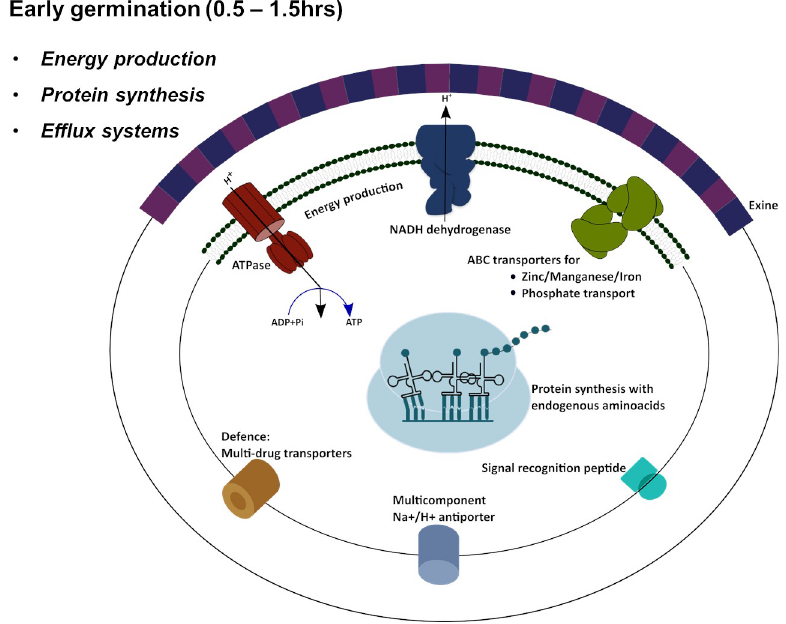
Fig 3. Diagram of cellular processes that undergo an increase in expression during the early germination period (0.5 to 1.5 hrs.).